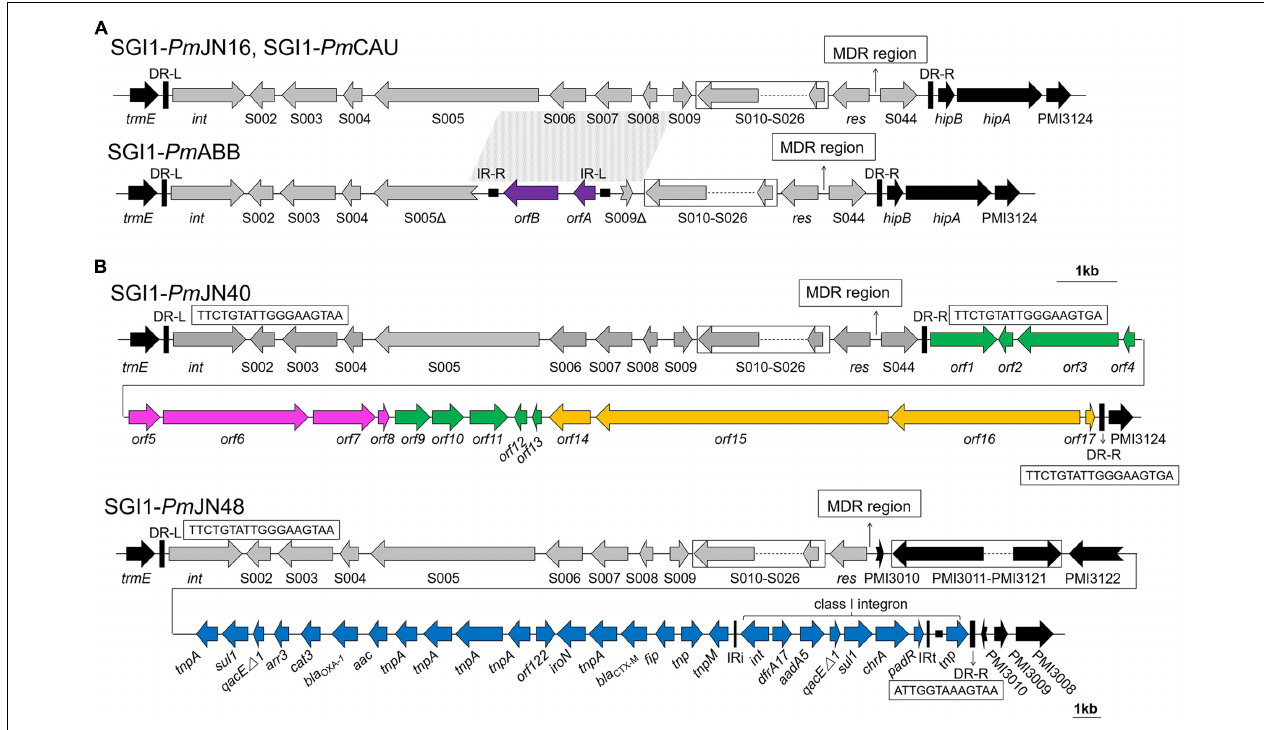
FIGURE 1 | Backbone structures of SGI1s identified in this work. (A) Backbone structures of SGI1- Pm CAU, SGI1- Pm ABB, and SGI1- Pm JN16. (B) Backbone structures of SGI1- Pm JN40 and SGI1- Pm JN48. SGI1 backbones are shown with different colored arrows based on their origins: SGI1 conserved backbone (gray), IS 1356 (purple), chromosomal DNA of Vibrio parahaemolyticus (green), chromosomal DNA of Shewanella bicestrii (pink), chromosomal DNA of Photobacterium damselae (orange), p Pm 14C18 (blue), and chromosomal DNA of Proteus mirabilis (black). The direct repeats of SGI1 (DR-L/DR-R) and inverted repeats of class I integron (IRi/IRt) are indicated by thick vertical bars and thin vertical bars, respectively. The small filled squares represent inverted repeats of the IS. The position of the MDR regions is indicated by thin arrows. Truncated genes are shown by swallowtail